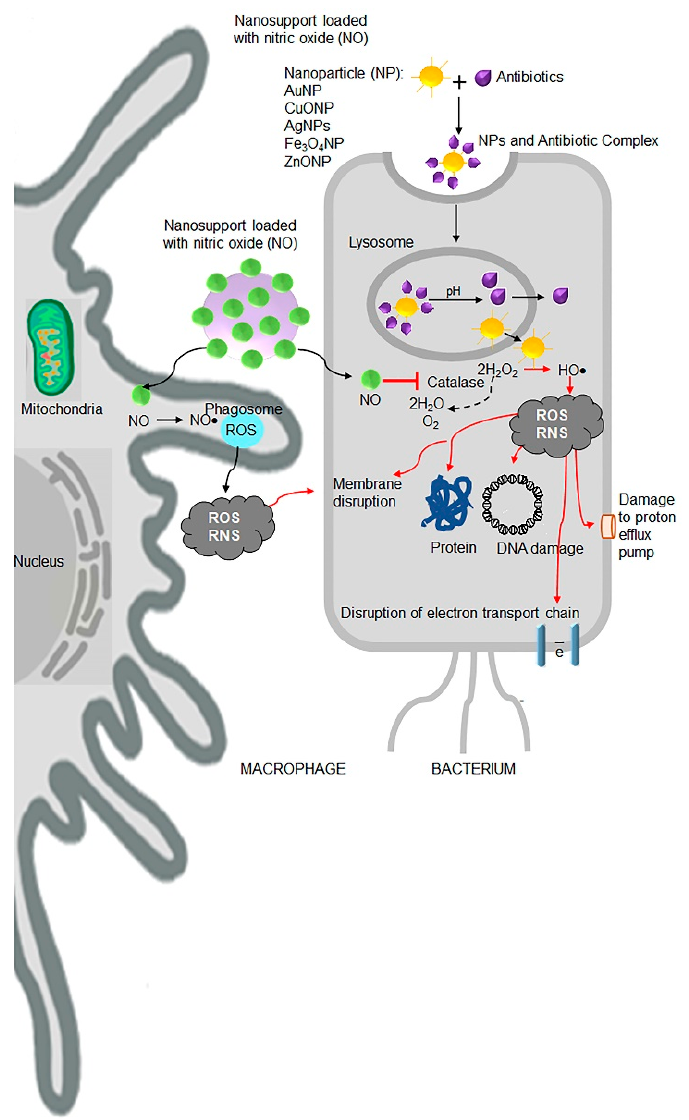
Figure 5. Schematic principle of action by nano-antibiotic therapies including nitric oxide (NO) releasing nanoparticles and nanoparticles in combination with antibiotics. The various nano-antibiotics (nAbts, purple shape) and NO-releasing nanoparticles (green circles) act via two components: metal ions (Ag + , Cu 2 + , Zn 2 + ) (yellow particle in the centre) and a releasing component such as NO with or without antibiotics. Both components increase production of reactive oxygen species (ROS) in the bacterium as well as in the host immune cells (e.g., macrophages, neutrophils). Left panel, in the bacterium, NO inhibits catalase activity, which leads to rise in levels of hydrogen peroxide. In the presence of transition metals of nanoparticles catalyse conversions of hydrogen peroxide to a hydroxyl radical (HO • ). Hydroxyl radical is one of many ROS and RNS responsible for oxidative and nitrosative stress and death of bacteria. ROS leads to disruption of cell membrane, interruption of transmembrane electron transport, oxidation of cellular components, protein and DNA damage. These actions disrupt structural and functional integrity of